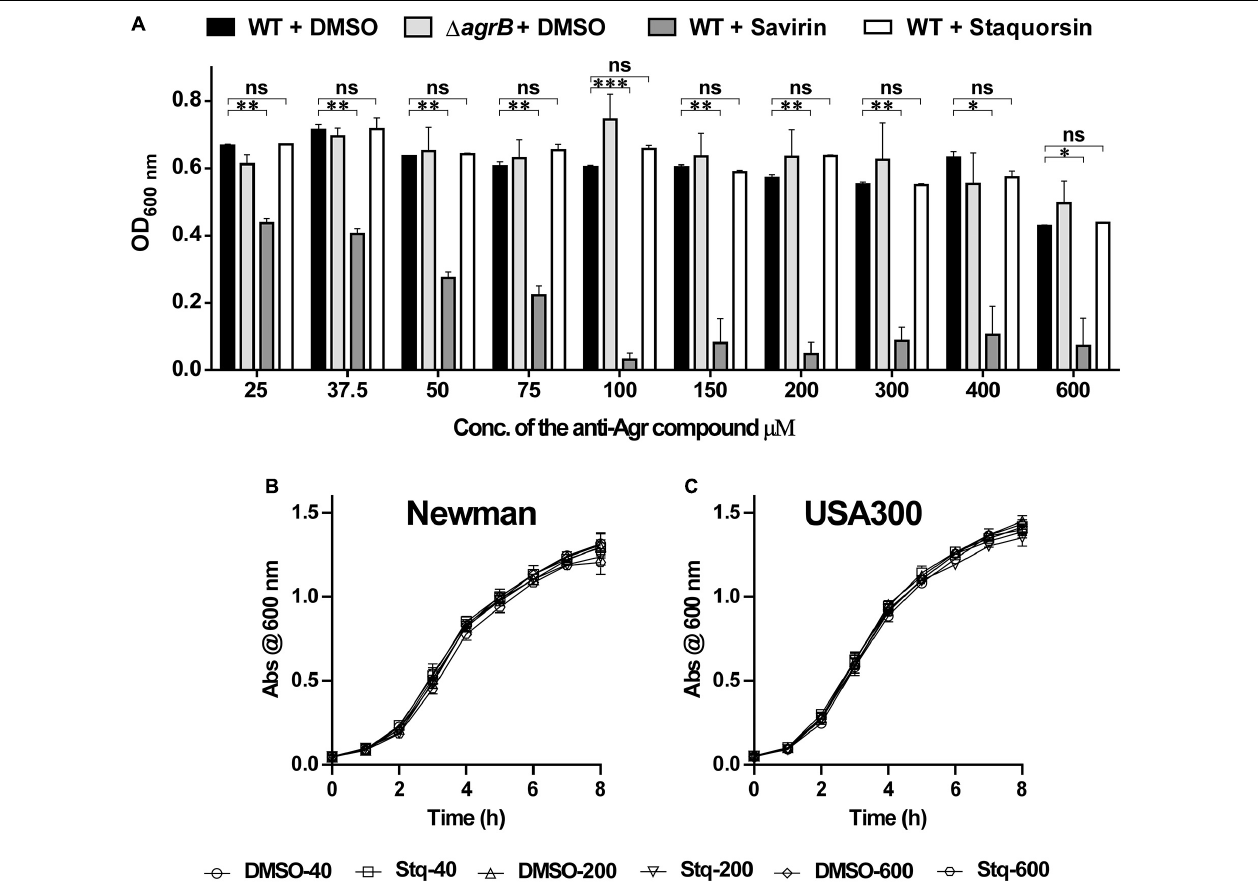
FIGURE 4 | Staquorsin does not affect cell viability in very high concentrations as opposed to savirin. (A) Optical density of the bacterial culture after incubation for 24 h, in the presence of staquorsin (white bars), compared to the previously established quorum sensing inhibitor savarin (dark gray bars), the WT (black bars) and (cid:49) agrB (light gray bars) grown in the presence of equivalent volumes of the vehicle (DMSO) used for dissolving the anti-Agr compounds. Effect of increasing concentrations of staquorsin on the growth kinetics of the MSSA strain Newman (B) and the MRSA strain USA300 (C) . Cell were grown in the indicated concentration of either staquorsin (Stq) or DMSO and the optical density at 600 nm was recorded at the indicated time points. The data presented is the average of three independent experiments and the error bars are the standard deviation. Statistical analyses were performed by applying ordinary one-way ANOVA followed by Tukey’s multiple comparisons test on the readings corresponding to each concentration. The “ns” indicates non-significant statistical difference ( p- value > 0.05), “ ∗ ” p- value ≤ 0.05, “ ∗∗ ” p- value ≤ 0.01, and “ ∗∗∗ ” p- value ≤